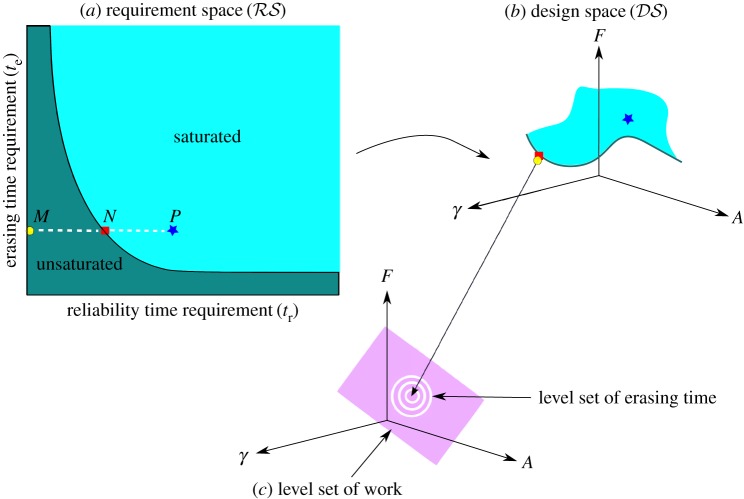
An illustration of the mapping of requirement specifications to optimal designs. The design space (DS) is divided by a curve corresponding to the reliability and erasing times of trapped designs. Points M,N in (a) requirement space (RS) having the same erasing time requirement get mapped to the same optimal bit in (b) design space : a trapped design with τr and τe equal to the requirements at N. The requirement specifications represented by points like P having the same te but greater tr than N are mapped to distinct points in design space. (c) A representation of a level set of work W within the design space, illustrating that the optimal designs to which unsaturated requirements are mapped minimize the erasing time among all designs requiring the same work.